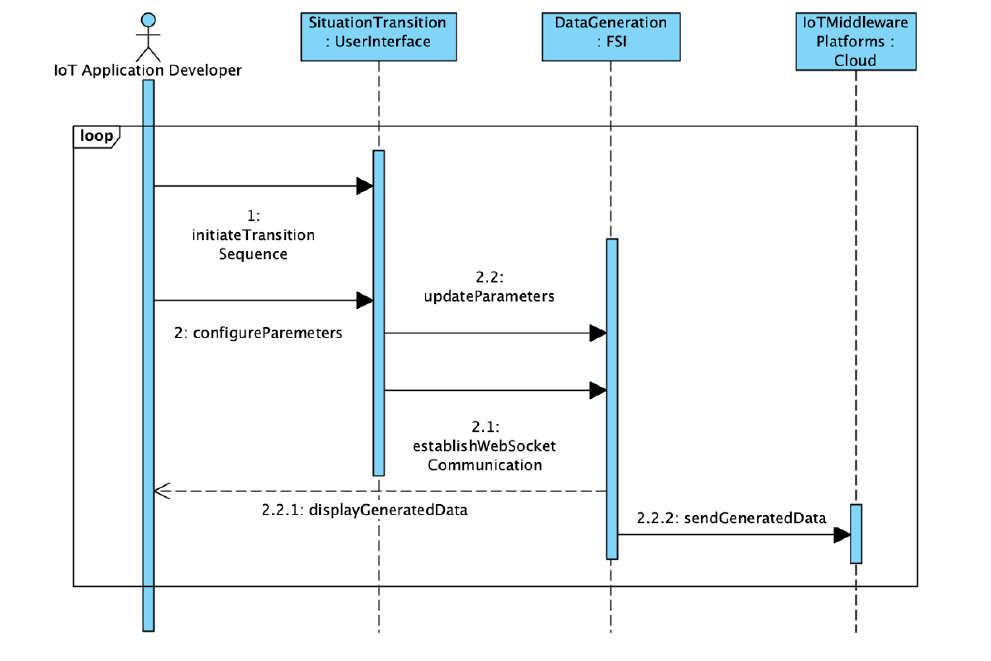
Figure 11. Running situation-based IoT data generation.